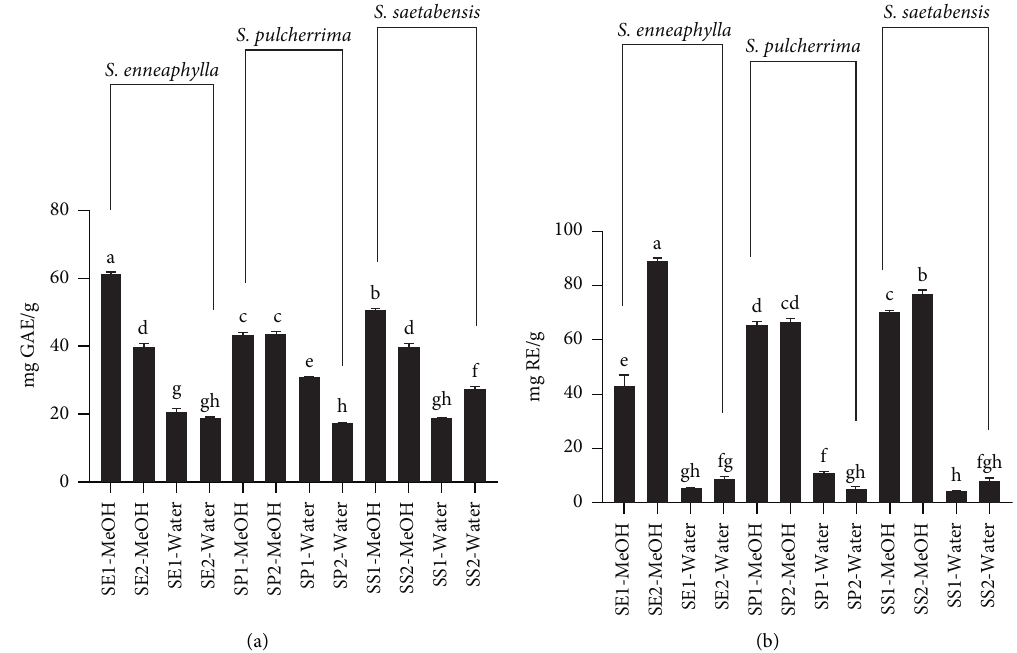
Figure 2: Total phenolic (a) and flavonoid (b) contents of the extracts by spectrophotometric assays. Values are expressed as mean ± S.D. of three parallel measurements. GAE: gallic acid equivalents; RE: rutin equivalents. Different letters indicate significant differences in the extracts ( p < 0 .